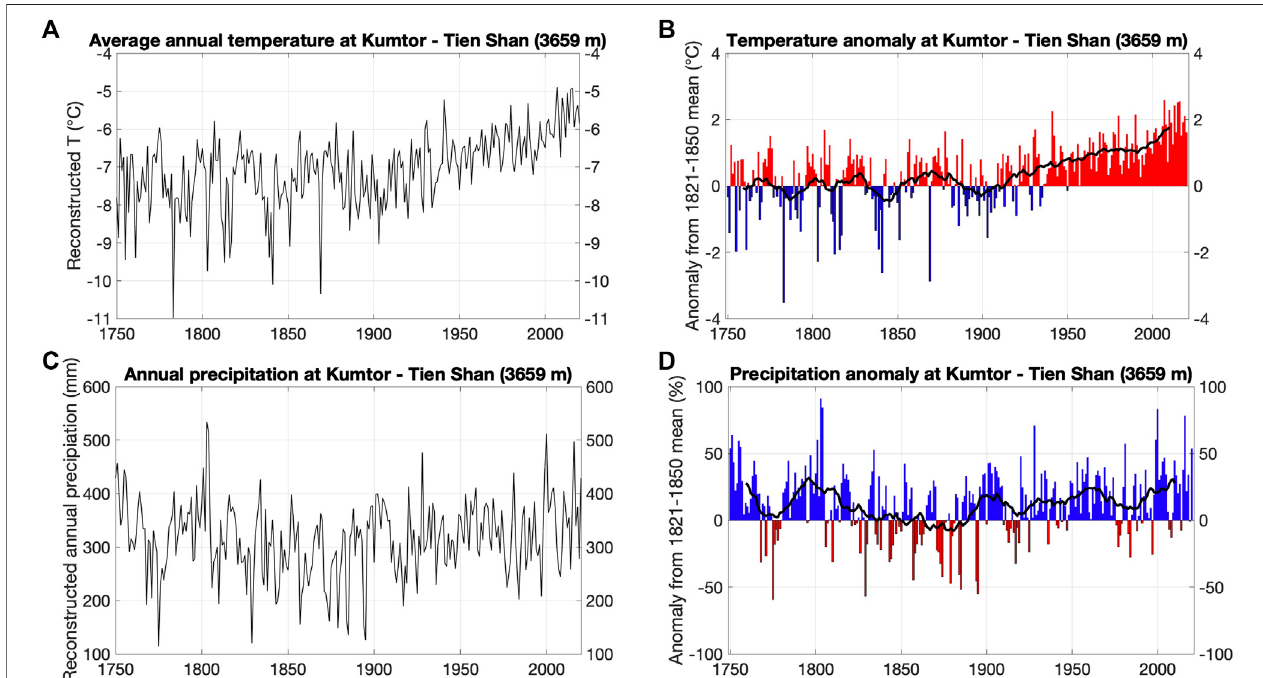
FIGURE 5 | Upper panels: Reconstructed and measured annual temperatures (A) and temperature anomalies (B) (from the 1821 – 1850 mean, assumed as the coldest period at the end of the LIA) at the Kumtor – Tien Shan meteorological station. Lower panels: Reconstructed and measured annual precipitation (C) and precipitation anomalies (D) (from the 1821 – 1850 mean) at the Kumtor – Tien Shan meteorological